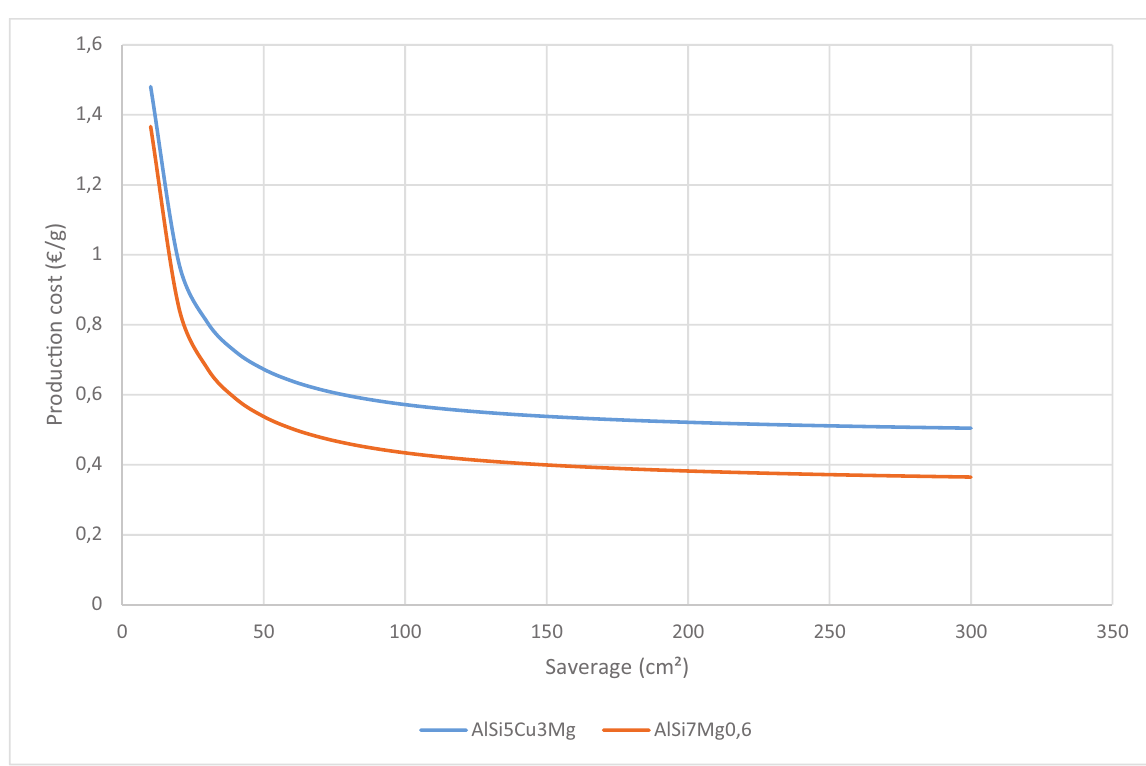
Fig. 17. Comparison of the production costs of the AlSi7Mg0.6 and AlSi5Cu3Mg alloys.